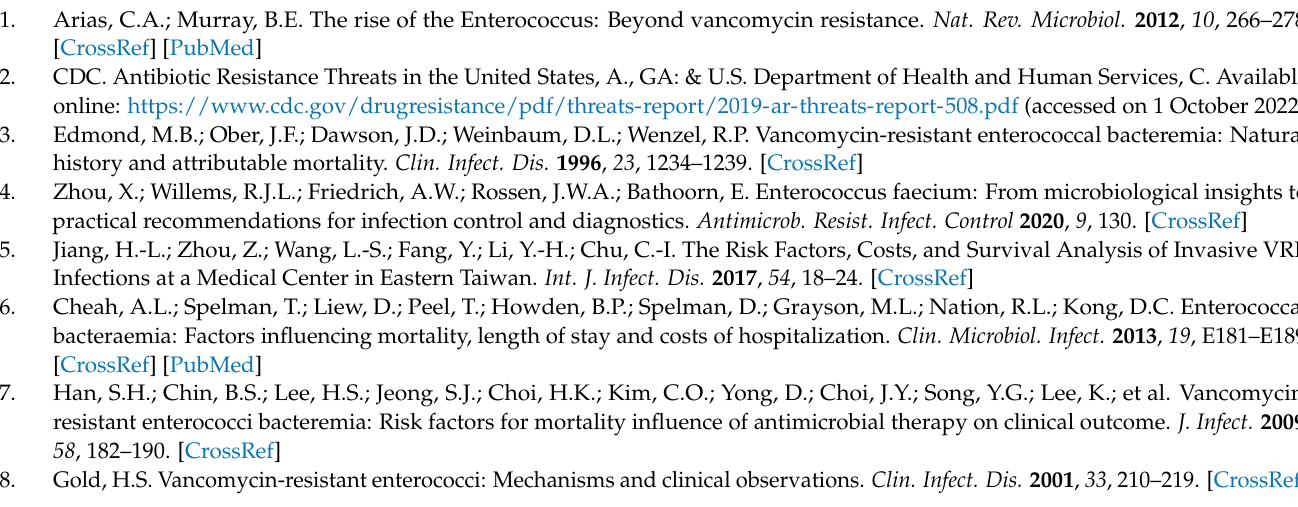
Table S2: ASP Staffing on Time to Optimal Therapy by Implementation Group; Table S3: Demograph- ics and Baseline Characteristics of Survivors vs. Non-survivors; Table S4: Multivariable Models for In-Hospital All-Cause Mortality in Overall Cohort; Table S5: Models for In-Hospital All-Cause Mor- tality by Subgroups; Table S6: Cox Proportional Hazard for 30-day In-Hospital All-Cause Mortality; Table S7: Multivariable Models for In-Hospital All-Cause Mortality by Delayed Optimal